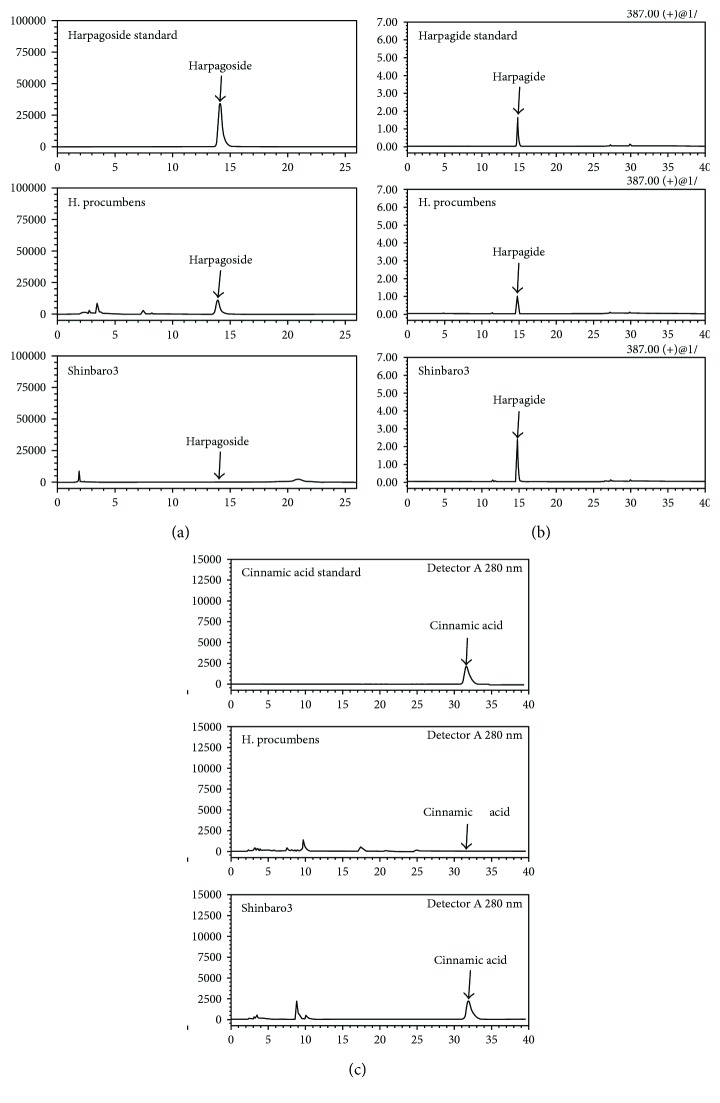
HPLC chromatograms of H. procumbens extract and Shinbaro3. HPLC chromatogram peaks corresponding to (a) harpagoside, (b) harpagide, and (c) cinnamic acid in H. procumbens extract (before hydrolysis) and alkaline-hydrolysed Shinbaro3 (after hydrolysis).